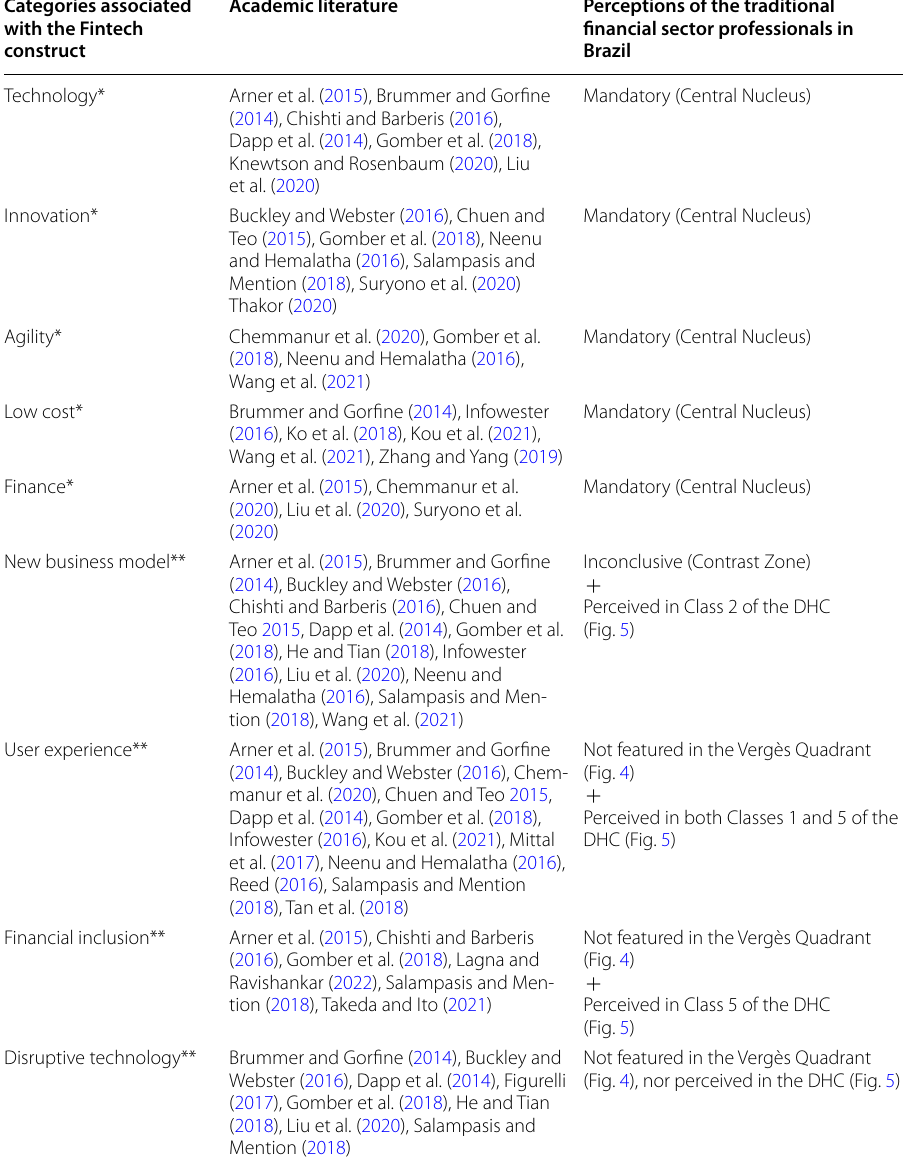
Table 4 Theoretical references versus social representation of